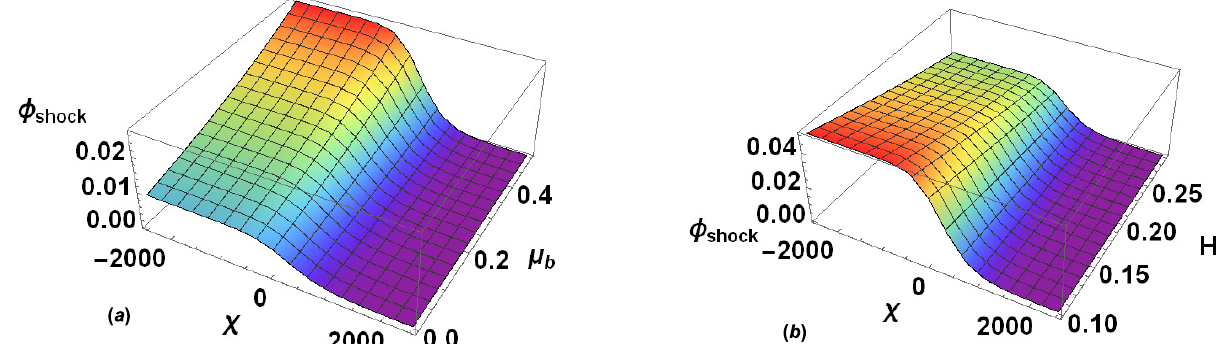
Figure 2. (Color online) Variation of the three-dimensional profile of the shock wave for different values of ( a ) ion-beam density ratio ( µ b ), ( b ) magnetic field strength ( H ), with fixed values of l z = 0.6, η = 0.4, V b 0 = 0.4, γ b = 0.5, and T = 0.2.